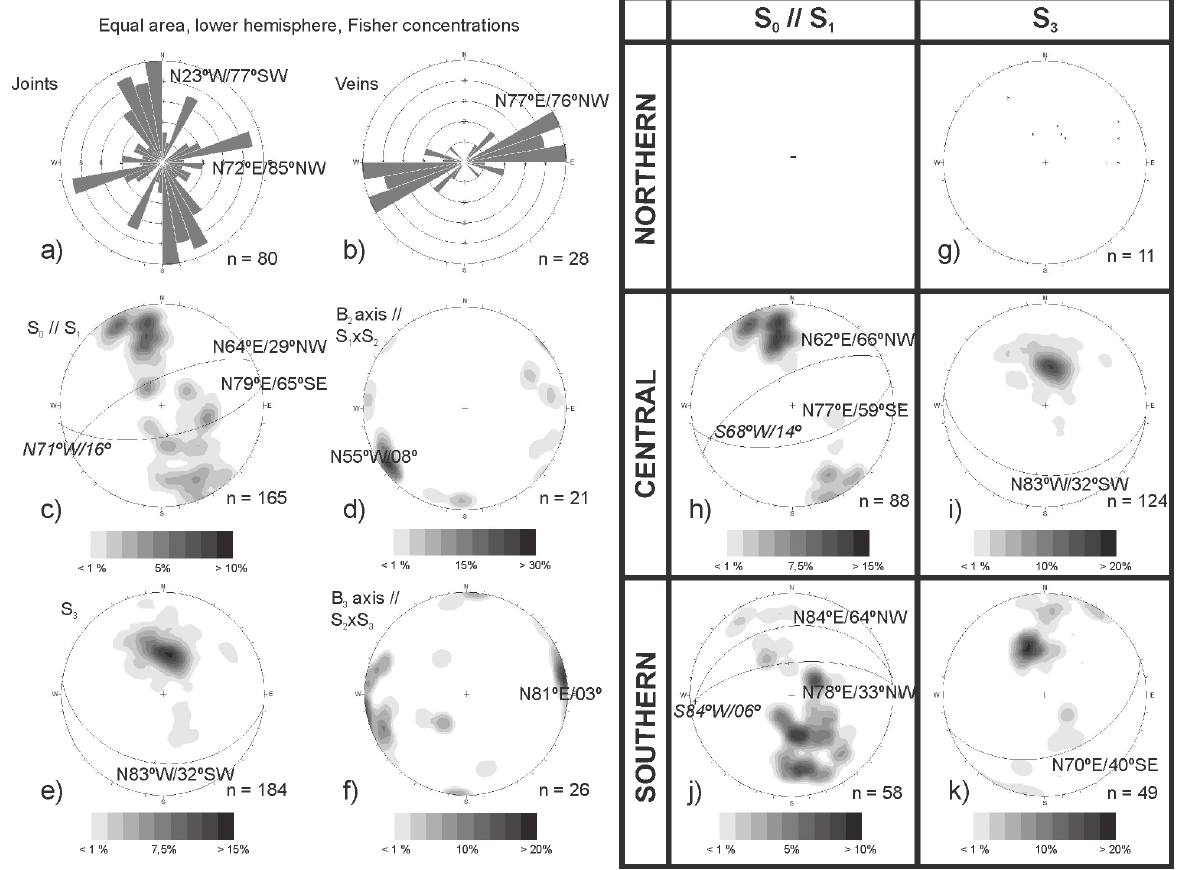
Figure 5 - Isoareal stereograms for structures of the Rio Preto fold